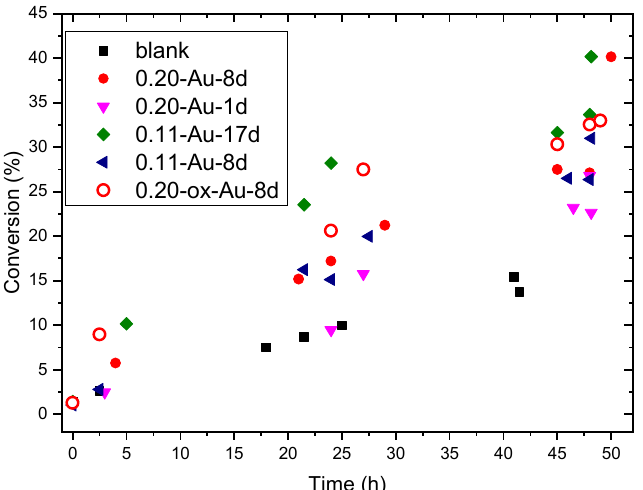
Figure 7. Conversion as a function of time for the liquid phase oxidation of cyclohexene with selected gold catalysts. Results of a blank test with gold-free SBA-15 are also shown for comparison.